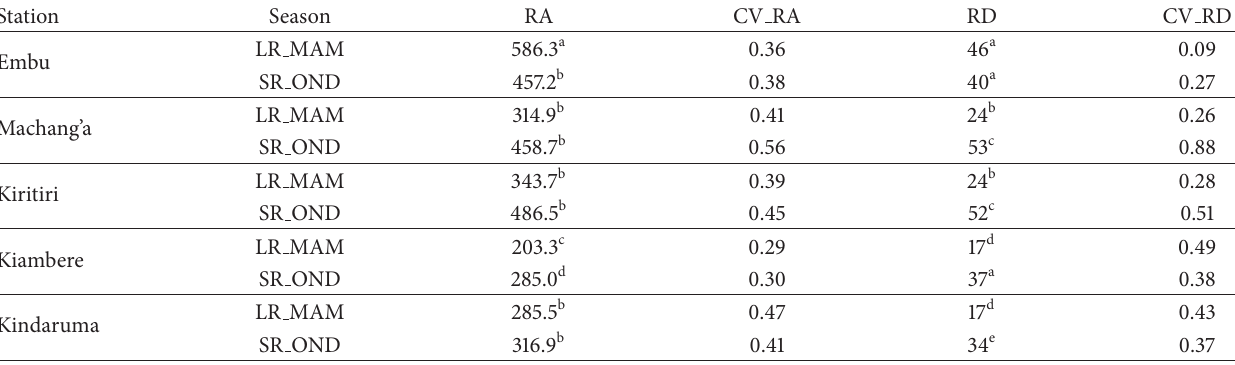
Table 5: Variability analyses: coefficient of variations in seasonal rainfall amounts and number of rainy days in the study stations for the period between 2000 and